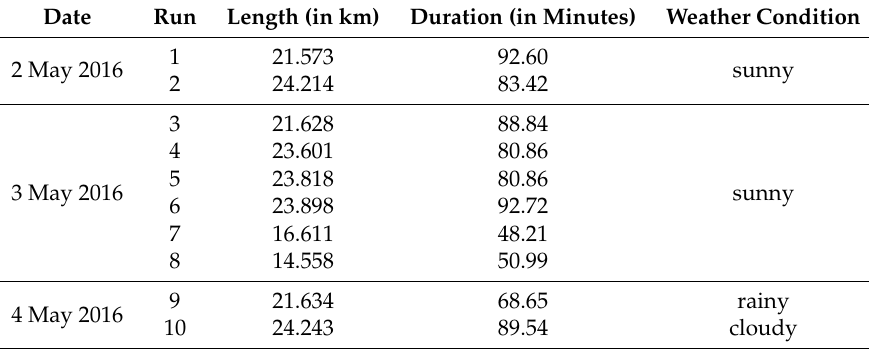
Table 1. Data acquisition details.